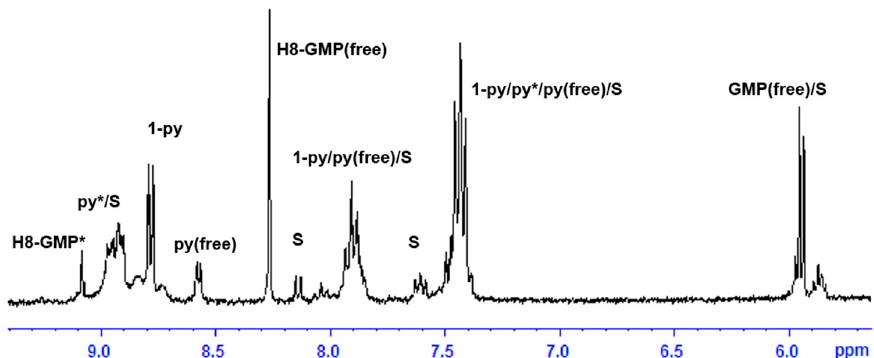
Figure 4. 1 H NMR spectrum of the reaction between complex 1 and 5 ′‐ GMP (acetone ‐ d 6 and D 2 O in a ratio 2:1) showing changes in the aromatic and aliphatic area after 1 h under irradiation at 37 °C. Labels: GMP(free), free 5 ′‐ GMP; H8 ‐ GMP*: H8 ‐ 5 ′‐ GMP coordinated adduct signal; 2 ‐ py, pyridine ligand signals of complex 2 ; py*, adduct pyridine signal, and S : speciation.